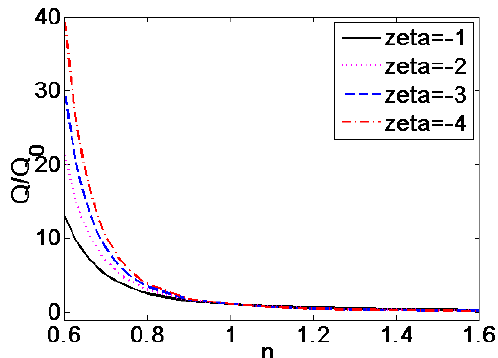
Figure 10. The variation of dimensionless volumetric flow rate generalized with the volumetric flow rate of Newtonian fluid ( n = 1) with flow behavior index n under the situation of different zeta potential ξ ( K = 50).